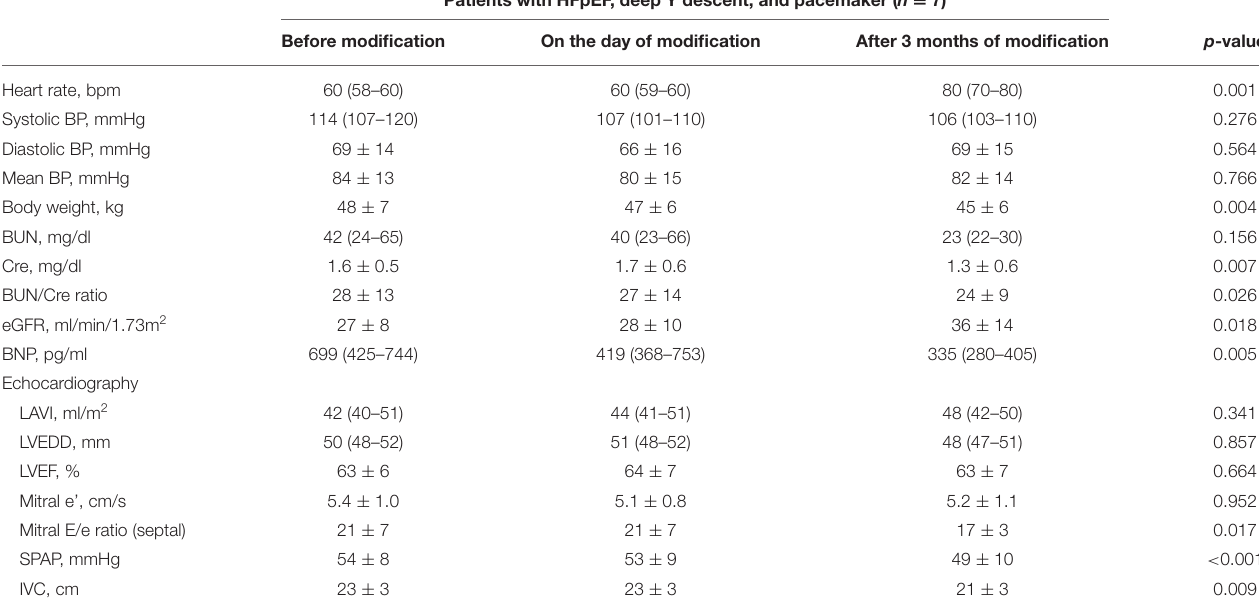
TABLE 5 | Effects of heart rate modification in patients with HFpEF and pacemaker. Patients with HFpEF, deep Y descent, and pacemaker ( n =